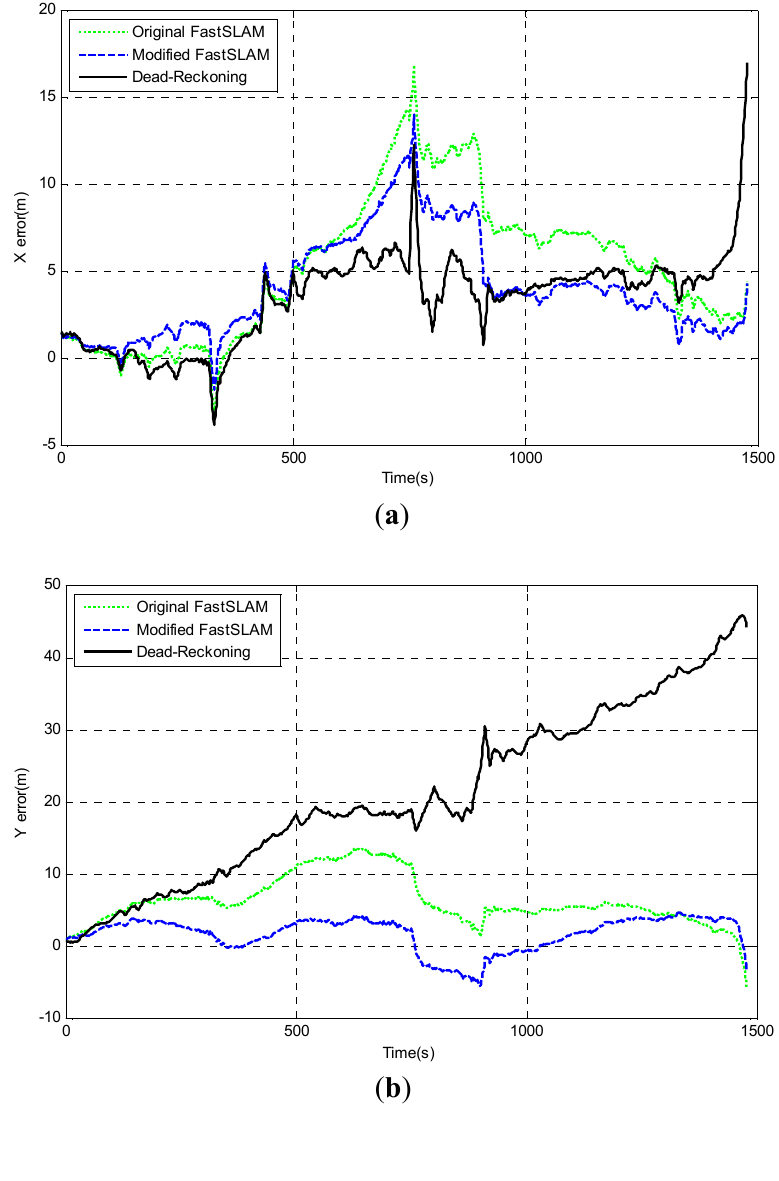
Figure 15. Pose errors between estimated pose and GPS ground truth. ( a ) Easting (x-axis) error; ( b ) Northing (Y-axis) error; ( c ) Heading-angle